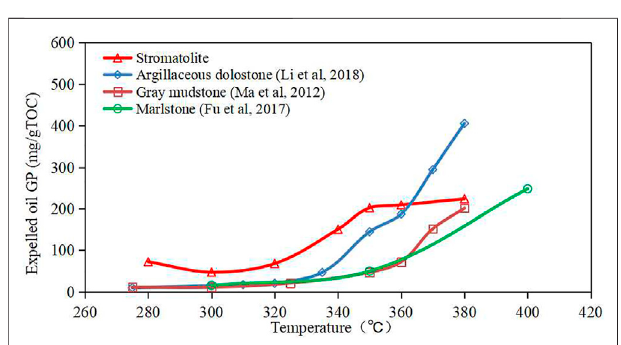
FIGURE 8 | Comparison of expelled oil generation